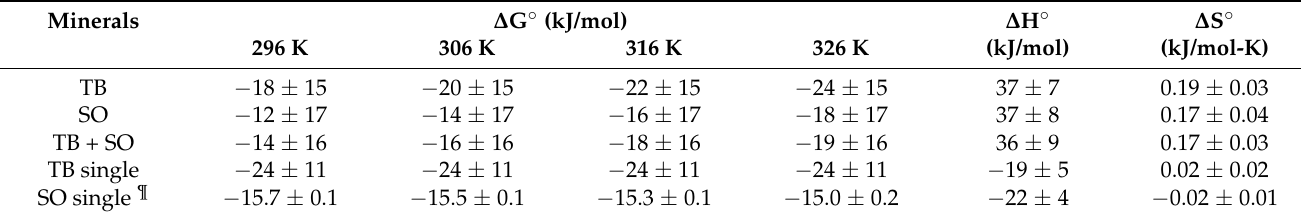
Table 2. Thermodynamic parameters of TB and SO sorption on ZEO from single and binary solutions.